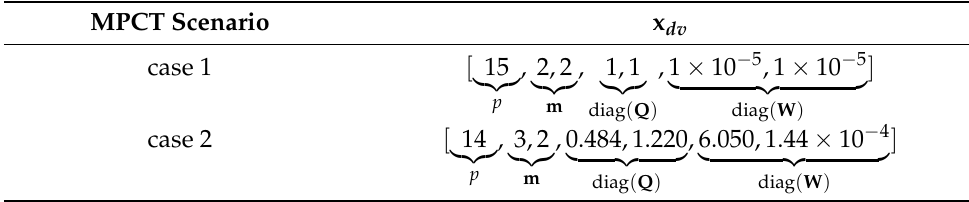
Table 4. Tuning parameters for Van de Vusse reactor.